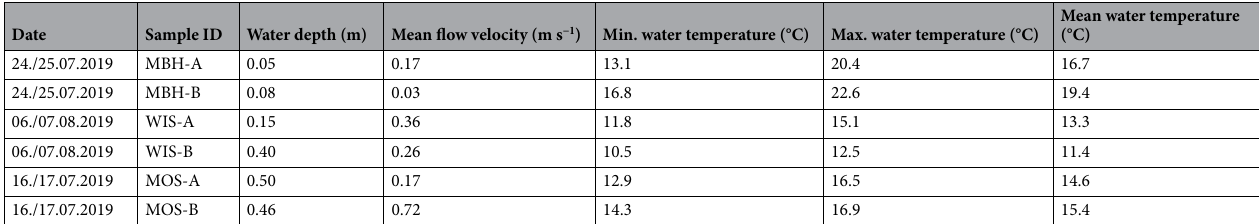
Table 2. Overview of water depths, mean flow velocities and water temperature minima, maxima and averages of the upstream (A) and downstream (B) sampling sites at the streams Mähringsbach (MBH), Wiesent (WIS) and Moosach (MOS).